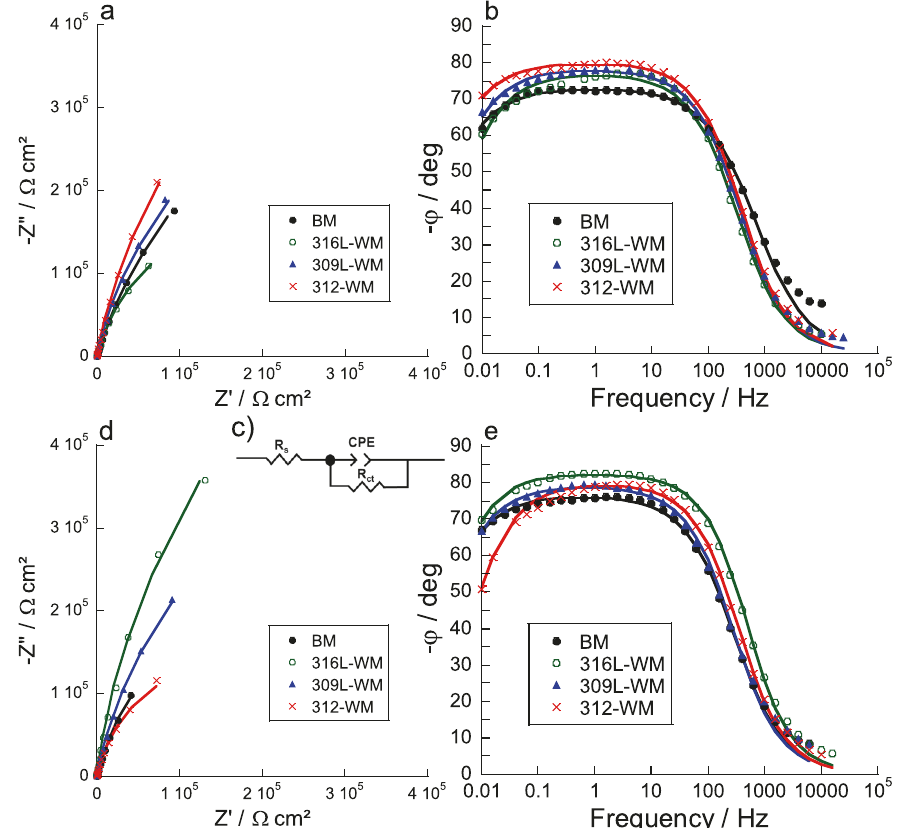
Fig. 5 EIS. Representative Nyquist ( a , d ) and Bode ( b , e ) plots of BM and weldments after 1 h immersion at 25 °C in PBS ( a , b ) and PBS + 10 g L -1 WP ( d , e ). c Data fi tted with one constant equivalent electrical circuit